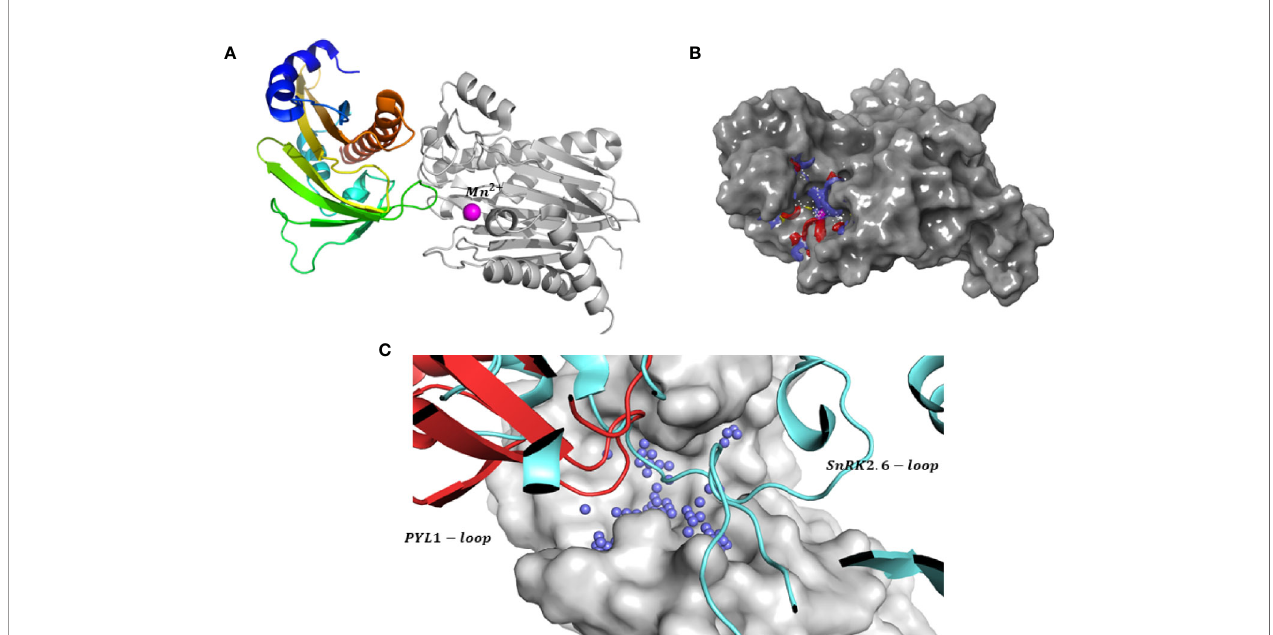
FIGURE 2 | Strategy for identi fi cation of novel inhibitors. (A) Structure of PYL1-ABI1 complex (PDB code: 3KDJ). PYL1 is shown in color scale, while ABI1 PP2C is shown in grayscale. The manganese ion is shown as a pink sphere; (B) Target (gray surface) and a putative binding site (shown as blue red mesh): a metal ion is included at the binding site; (C) Comparison between proposed binding site (blue spheres) and interaction surface of PYL1 (shown as red cartoons) and SnRK2.6 (shown as light blue cartoons) and ABI1 (shown in gray surface representation).